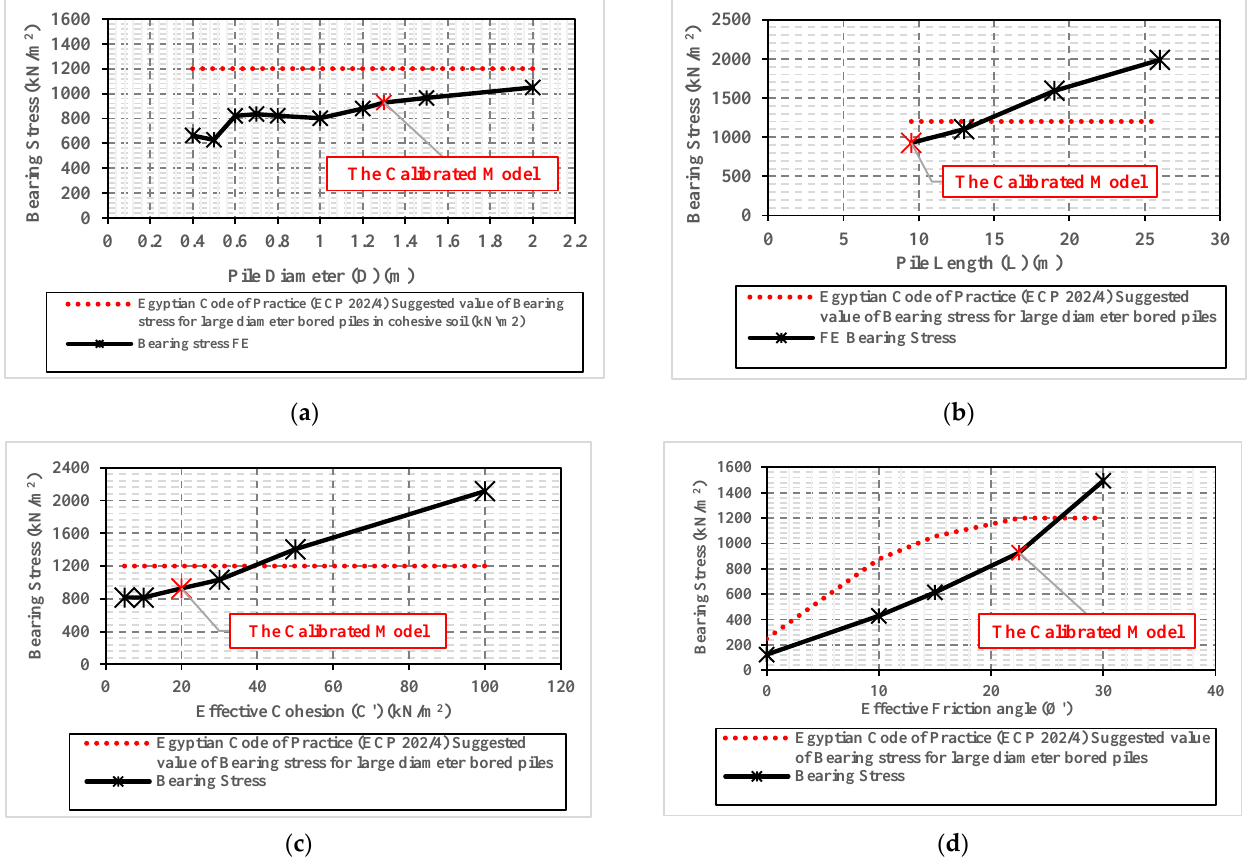
Figure 7. Influence in bearing stress with various parameters. ( a ) Pile diameter (D). ( b ) Pile length (L). ( c ) Effective cohesion (c’). ( d ) Effective friction angle (Ø’).